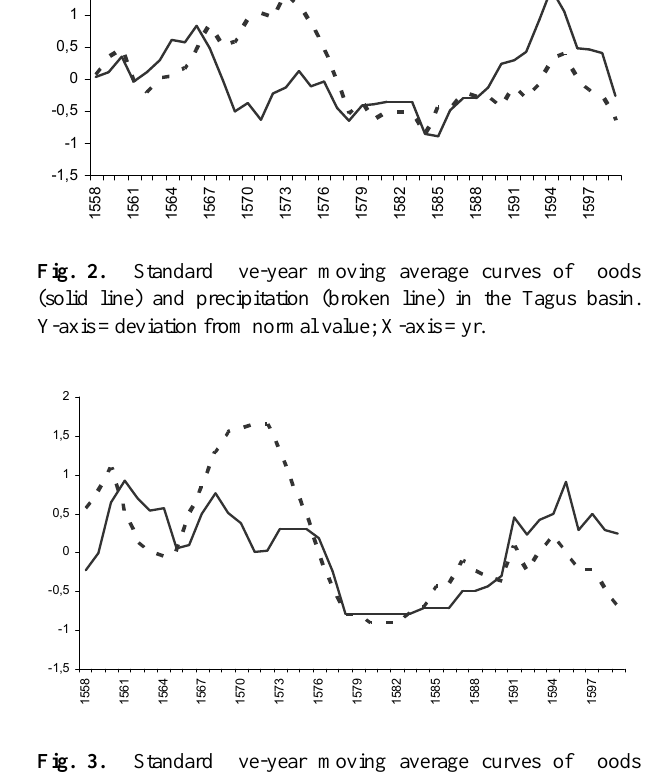
Fig. 3. Standard five-year moving average curves of floods (solid line) and precipitation (broken line) in the Duero basin. Y-axis = deviation from normal value; X- axis = years.